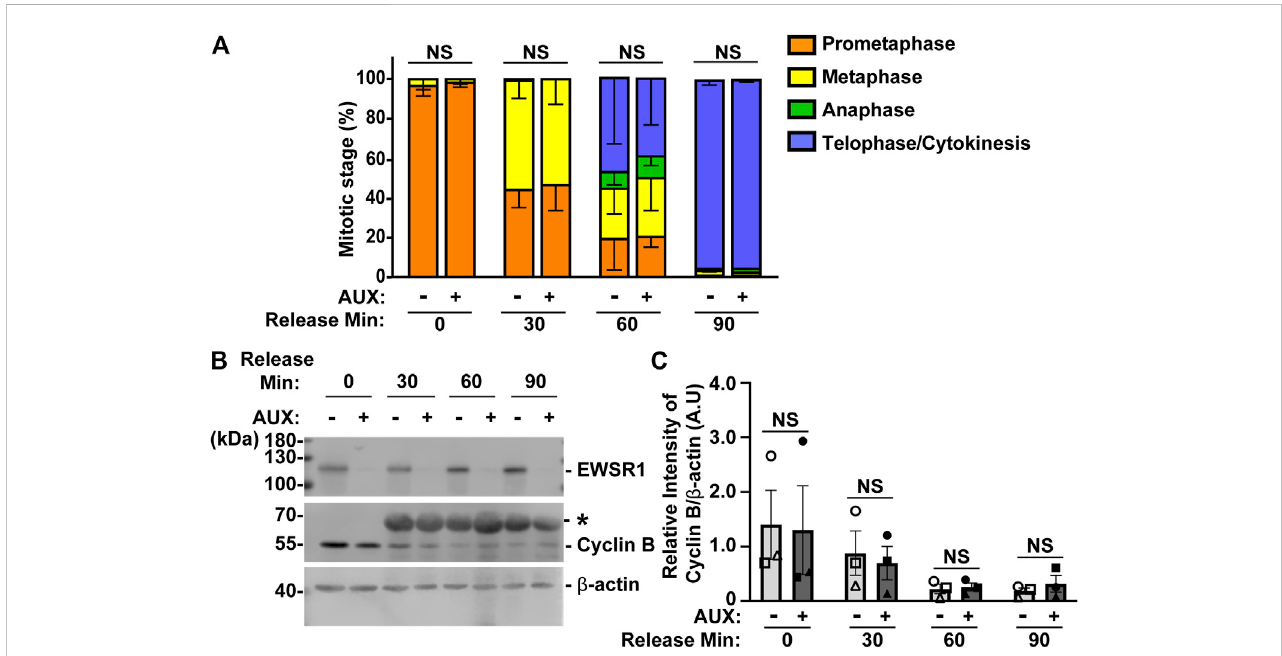
FIGURE 5 The EWSR1knockdown cells do not arrest at anymitotic stages. (A) . The percentagesof mitotic stage of AUX- and AUX + cells released for 0, 30, 60and 90 min after the thymidine/nocodazole treatment (total of 83 – 173 cells per sample, n = 3 experiments). NS = non-signi fi cant. (B) . Representative images of western blotting using anti-FLAG (top panel), anti-Cyclin B (middle panel) and anti- β actin (bottom panel) obtained from AUX- and AUX + cells released at 0, 30,60,and90 minafterthethymidine/nocodazoletreatment.*:Non-speci fi cband. (C) .Quanti fi cationofthelevelsofCyclinBprotein(normalizedby β - actin) obtained from AUX- and AUX + cells ( n = 3 experiments). Images of western blotting gelusing anti-EWSR1 (top panel), anti-CyclinB(middle panel), and anti- β -actin antibodies (bottom panel). Values are mean with S.D. using two-way ANOVA with Tukey ’ s multiple comparison test. NS: Non-Signi fi